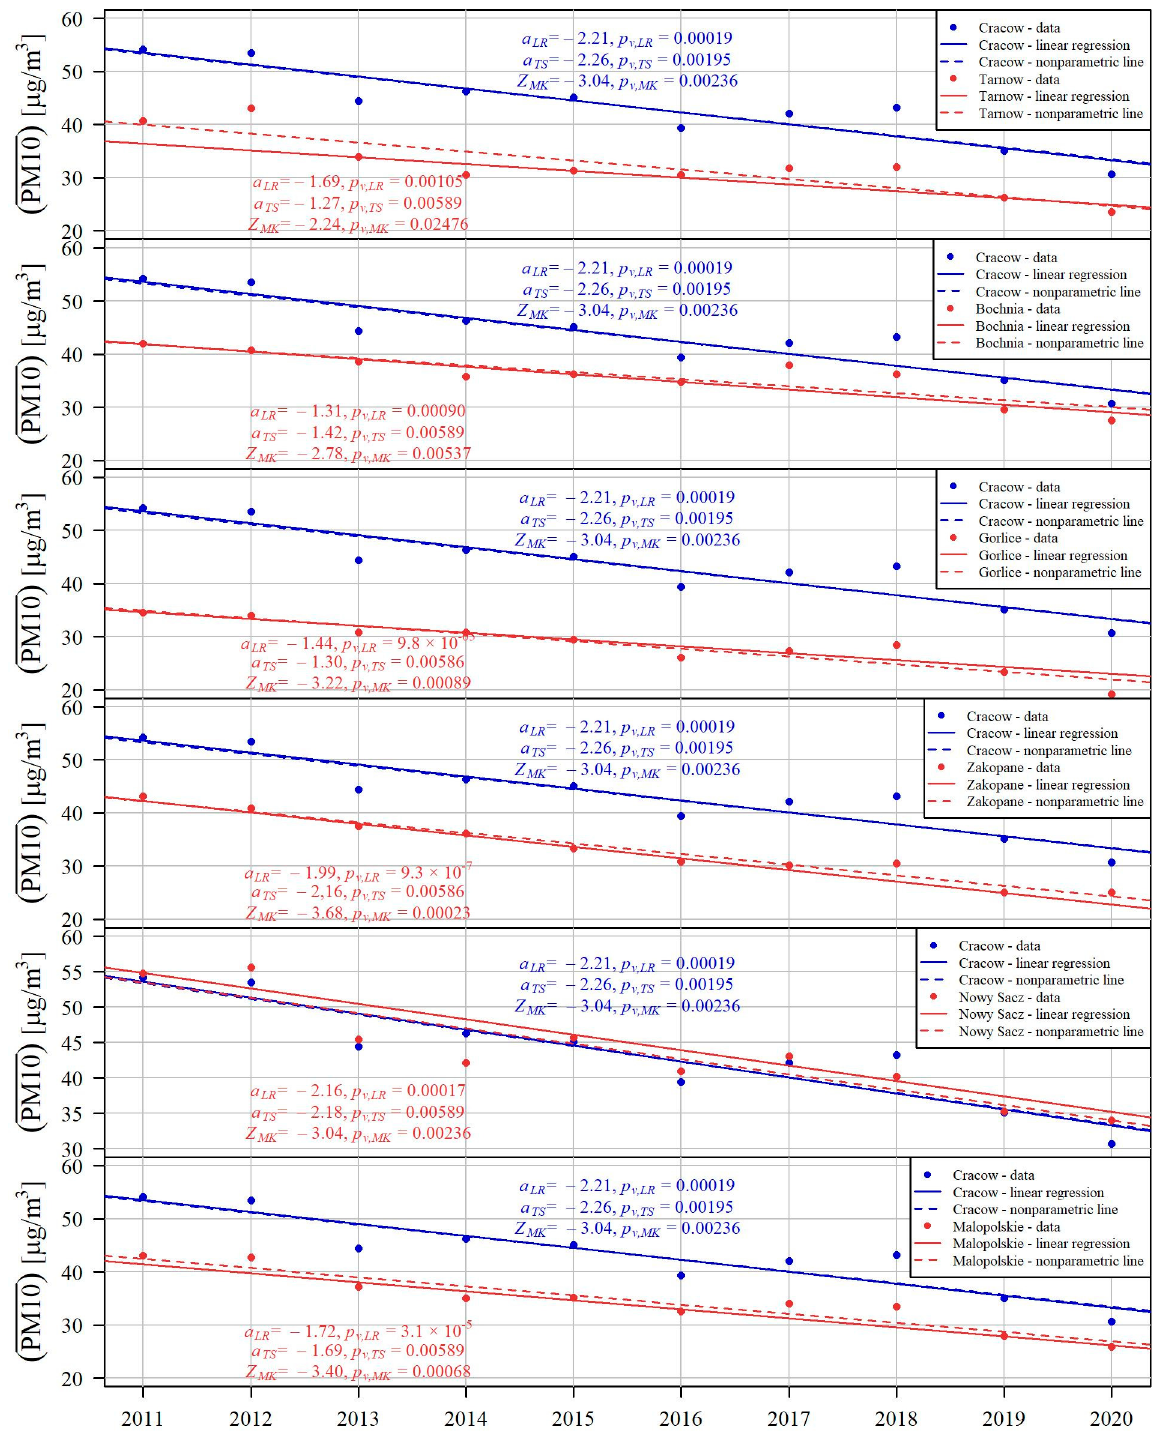
Figure 4. Comparison of the distributions of average annual concentrations of PM10 in Cracow and the analyzed cities of the Malopolskie Voivodeship in 2011–2020. Significant ( p v , MK < 0.05) decreasing trends shown using Theil–Sen line with significant slope a TS [µg/m 3 /year] ( p v , TS < 0.05). Linear regressions with significant a LR [µg/m 3 /year] ( p v , LR < 0.05) are shown for comparison. Malopolskie means the arithmetic mean of the values for individual analyzed cities, excluding Cracow. (Source: own elaboration based on the data from the database of the Chief Inspectorate for Environmental Protection [29]).